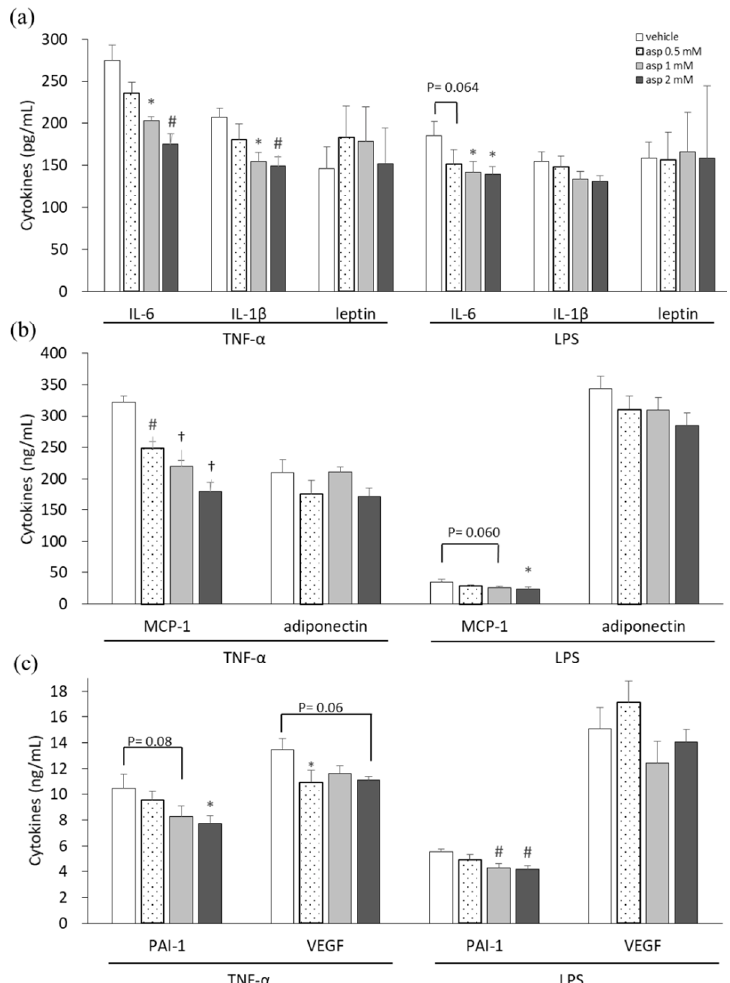
Figure 1. Aspirin inhibited proinflammatory cytokines, adipokines, and angiogenic mediators in 3T3-L1 adipocytes. 3T3-L1 adipocytes were induced with 10 ng / mL tumor necrosis factor-alpha (TNF- α ) and 1 µ g / mL lipopolysaccharide (LPS) stimulation and treated with various doses of aspirin for 24 h. ( a ) Interleukin-6 (IL-6), IL-1 β , and leptin in cell supernatants were analyzed using ELISA. ( b ) Macrophage chemoattractant protein-1 (MCP-1) and adiponectin production were analyzed using ELISA. ( c ) Plasminogen activator inhibitor-1 (PAI-1) and vascular endothelial growth factor (VEGF) production were analyzed using ELISA. Data are presented as mean ± SEM of at least three independent experiments. Statistical analysis was examined by one-way ANOVA and the least significant difference (LSD) post hoc test. Significance of difference is presented as * p < 0.05, # p < 0.01